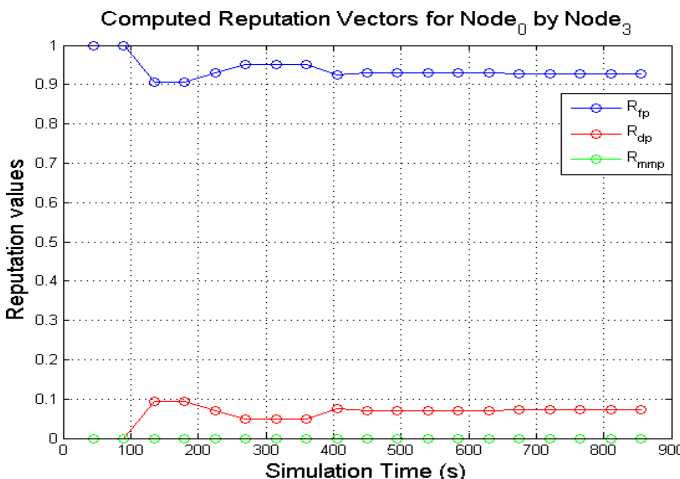
Figure 5. Reputation values for a good node ( N 0 ) calculated by another good ( N 1 ).